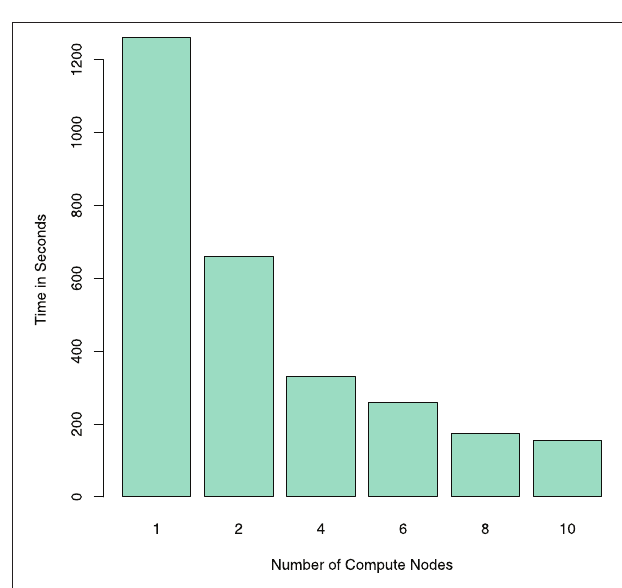
FIGURE 2 | Comparing the runtime (in seconds) for reading one resting-state fMRI dataset using NiftiImageReadMasked on an Apache Spark cluster with different numbers of compute nodes. Note that the reduction in computation time scales almost with 1/n, n being the number of nodes in the